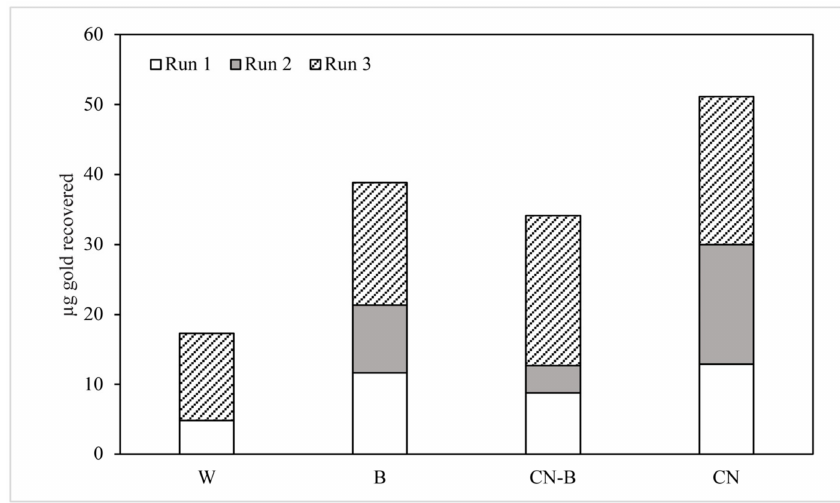
Figure 5. Au recovered from column effluents, in µ g. Symbology is the same as that used in Figure 4. Table 3. Weekly Au recovered from effluents for the three experimental runs, in µ g. The values shown below the detection limit of 25 ppb in Run 1 and Run 2, and 5 ppb in Run 3, are marked